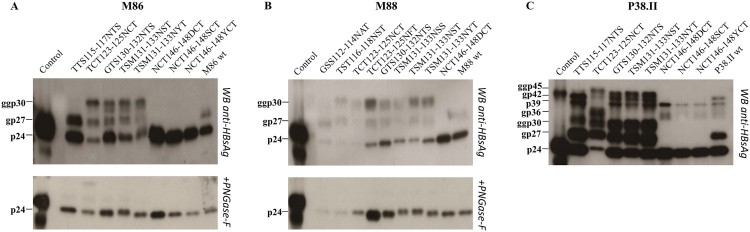
N-glycosylation patterns of mutants and wild-type HBV envelope proteins. HBV envelope proteins produced in transiently transfected HuH-7 cells were analyzed by western blotting using a rabbit R247 antibody targeting the S cytosolic loop. The glycosylated (gp) and nonglycosylated (p) forms of mutated recombinant proteins derived from plasmids M86 (A), M88 (B), and P38.II (C) are indicated. PNGase-F treatment results were also indicated.